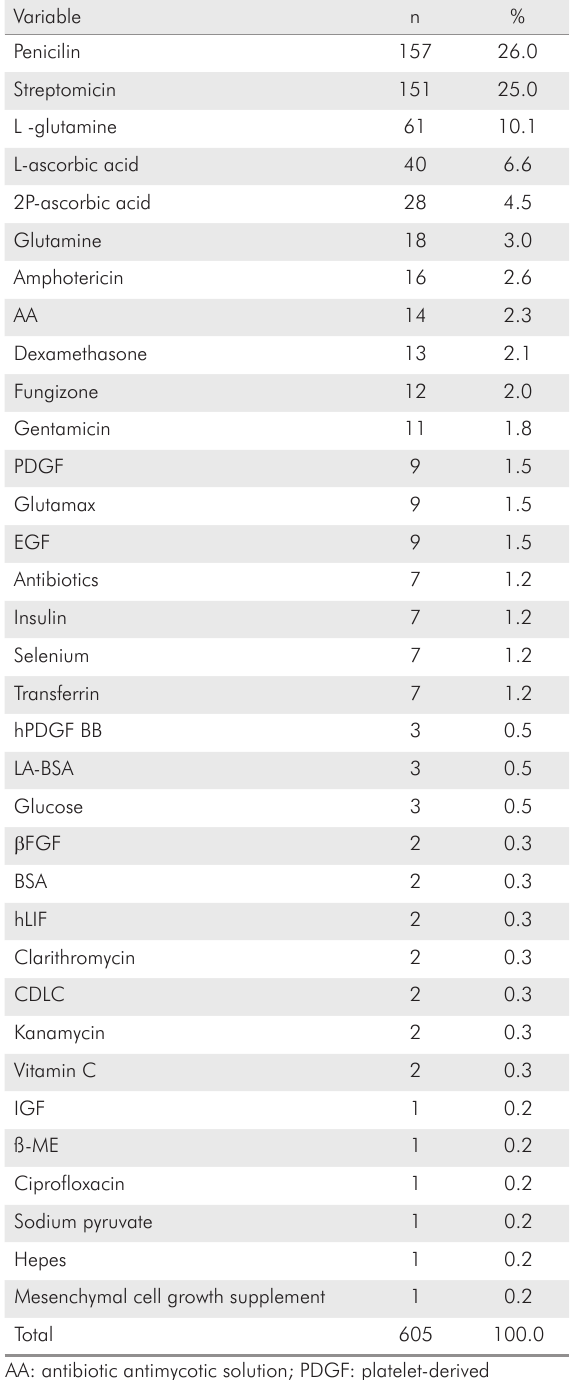
Table 4. Distribution according to the supplementation used in DPSCs culture medium preparation (some studies used more than one culture